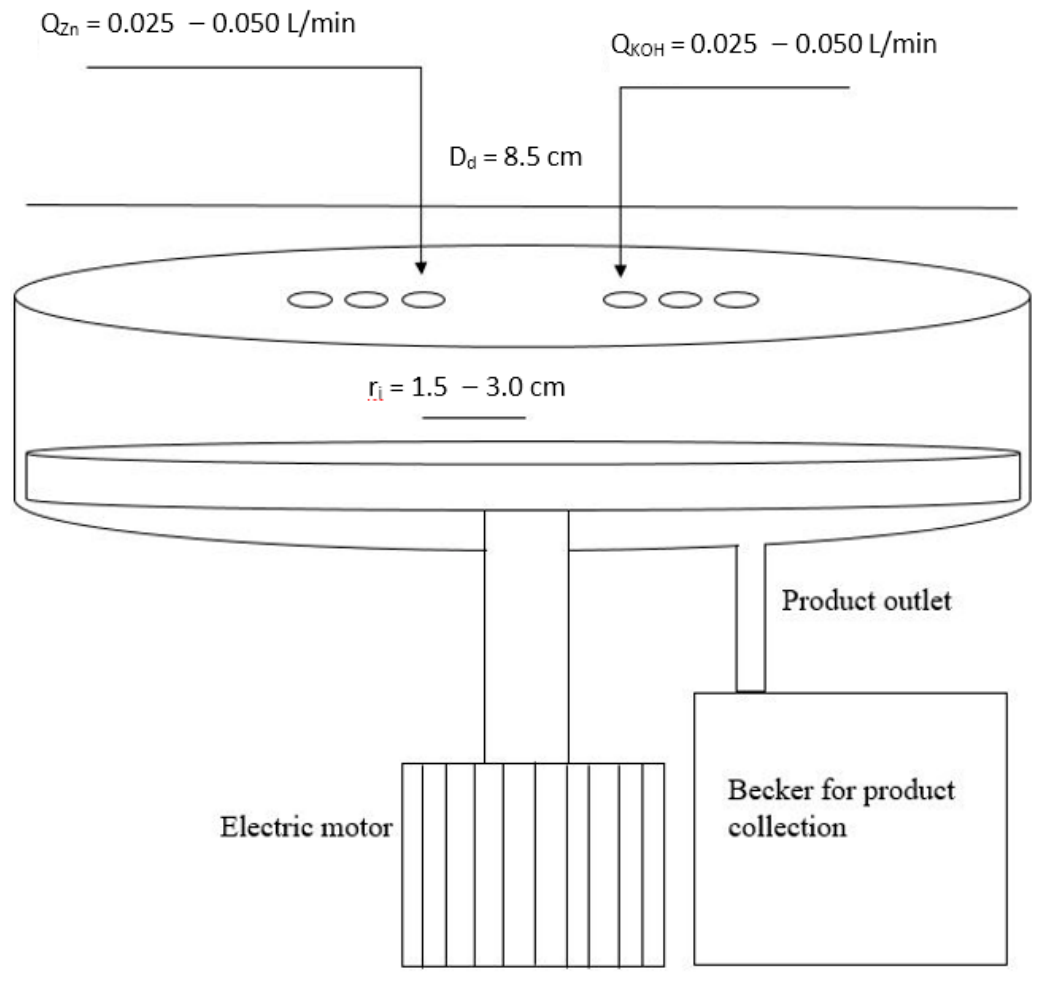
Figure 1. Spinning disk reactor (SDR) schematization. Table 1. Experimental conditions adopted in the 25 runs.